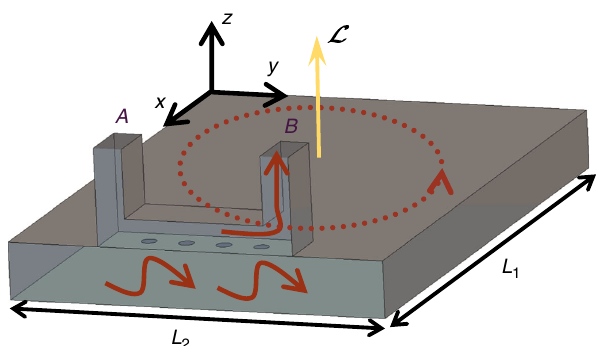
Fig. 6 Setup of a possible experiment at microwave frequencies. A metallic cavity is fi lled with a topological photonic crystal (not represented in the fi gure; e.g., a photonic crystal formed by ferrite rods 8 ) and is connected to a waveguide coupler through multiple apertures on the top metallic plate.